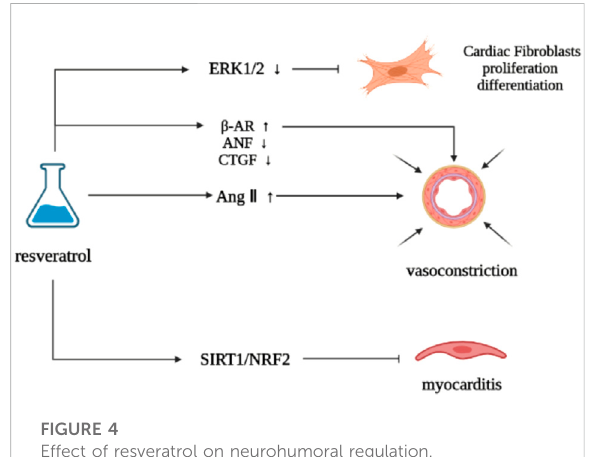
FIGURE 4 Effect of resveratrol on neurohumoral